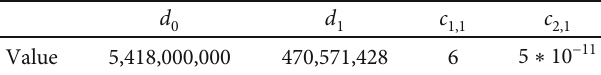
Table 3: Characteristics of the Moroccan milk market to be